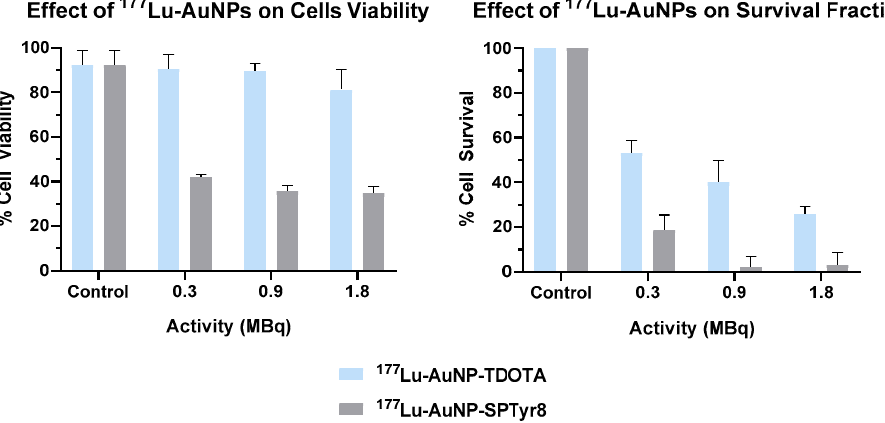
Figure 7. Results of the MTT ( left ) and clonogenic ( right ) assays for U373 cells treated with 177 Lu- AuNP-TDOTA or 177 Lu-AuNP-SPTyr8, compared with untreated control cells. Data are expressed as the percentage of cellular viability and percentage of survival fraction, respectively (mean ± SD).